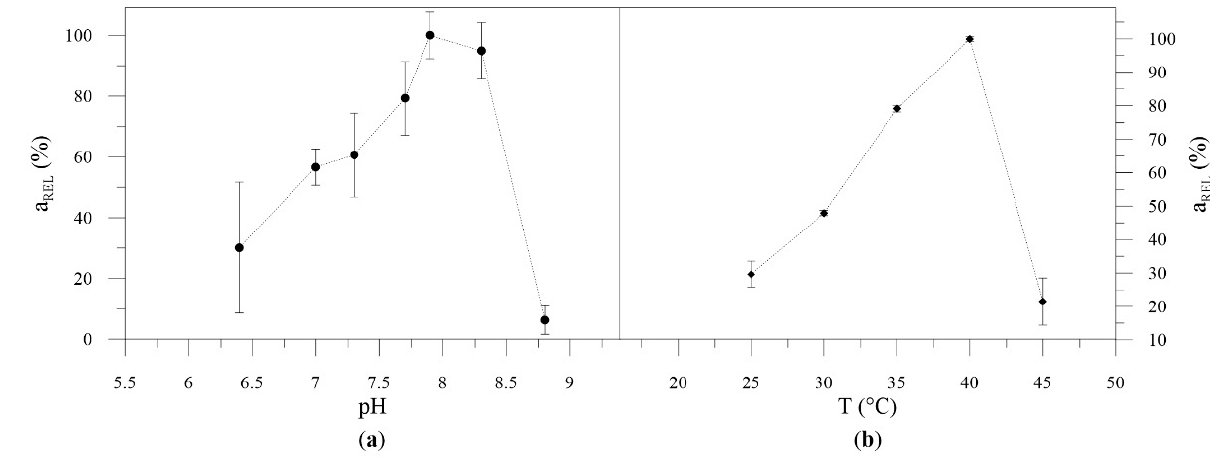
Figure 3. pH ( a ) and temperature ( b ) profile of purified SMO.